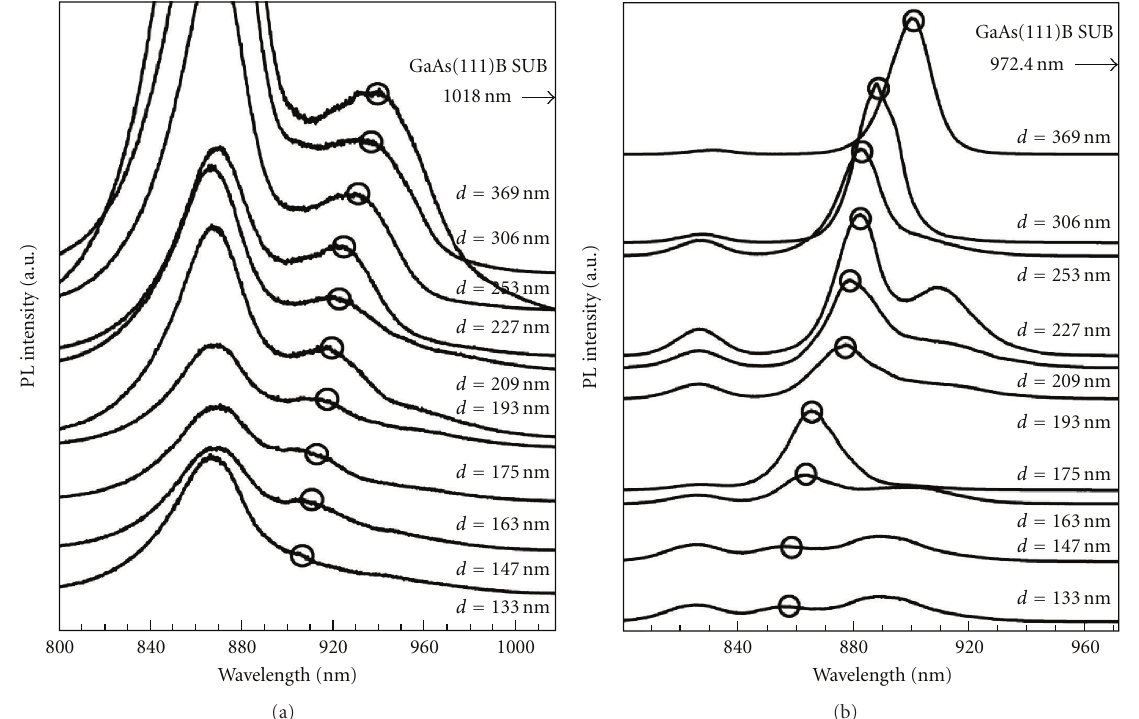
Figure 4: (a) Micro-PL spectra for sample I at room temperature (RT) and (b) at 77 K [28]. Open circles indicate the emission peaks of InGaAs.